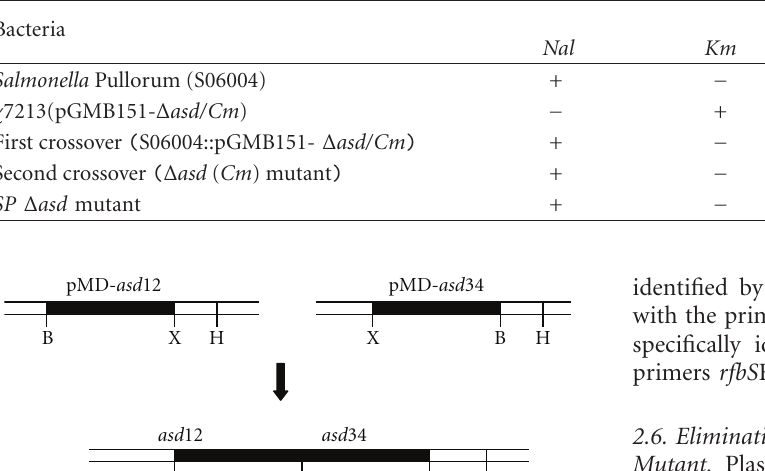
Table 3: Antibiotics resistance of bacteria during the selection of Δ asd mutant.